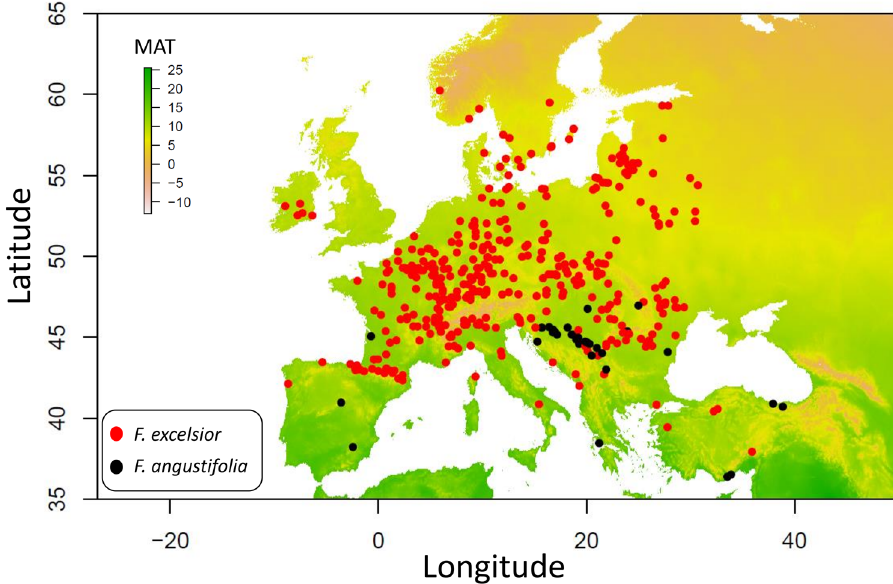
Figure 1. Overview of analysed survey plots from the ICP Forests Level I